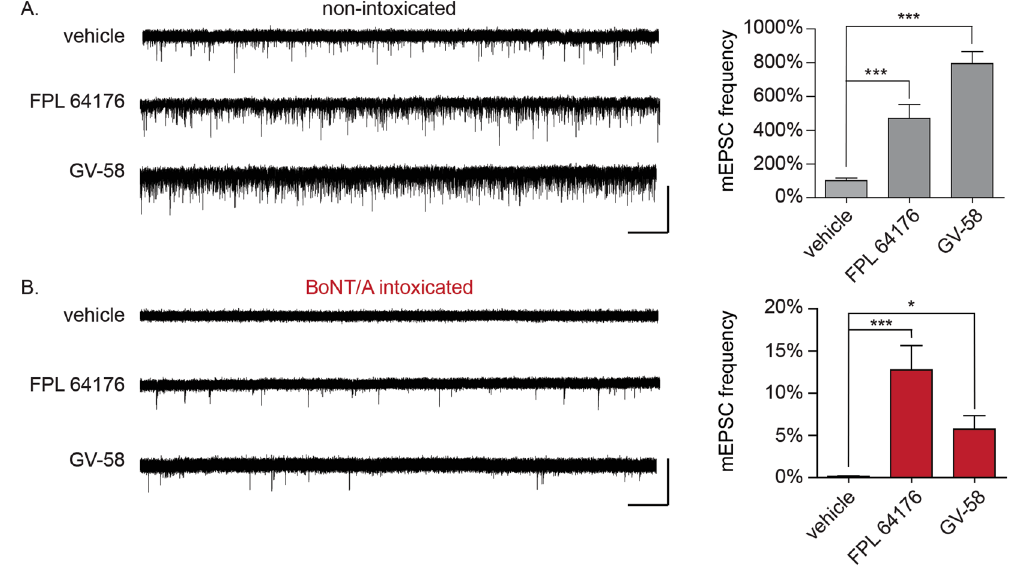
Figure 3. Use-dependent L-type or N/P/Q-type VGCC agonists restore spontaneous synaptic activity to neuronal cultures fully intoxicated by BoNT/A in physiological Ca 2 + . ( A ) Representative whole-cell recordings and mean mEPSC frequencies in non-intoxicated cultures treated with vehicle, FPL 64176 (10 µ M) or GV-58 (50 µ M). ( B ) Representative whole-cell recordings and mean mEPSC frequencies in BoNT/A-intoxicated cultures treated with vehicle, FPL 64176 (10 µ M) or GV-58 (50 µ M). mEPSC frequencies are normalized to recordings from age-matched, non-intoxicated control cultures. Scale bars represent 5 s (x-axis) and 40 pA (y-axis). All data presented as mean ± SEM and n ≥ 12 neurons for all conditions. * Indicates p < 0.05, *** Indicates p <